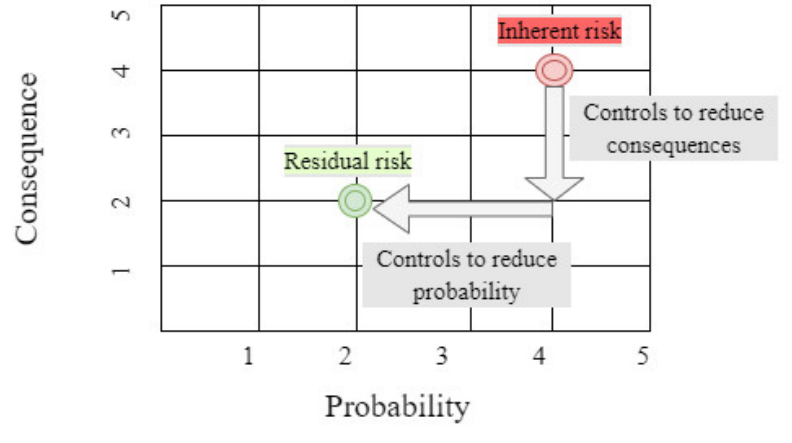
Figure 1. The risk reduction process.